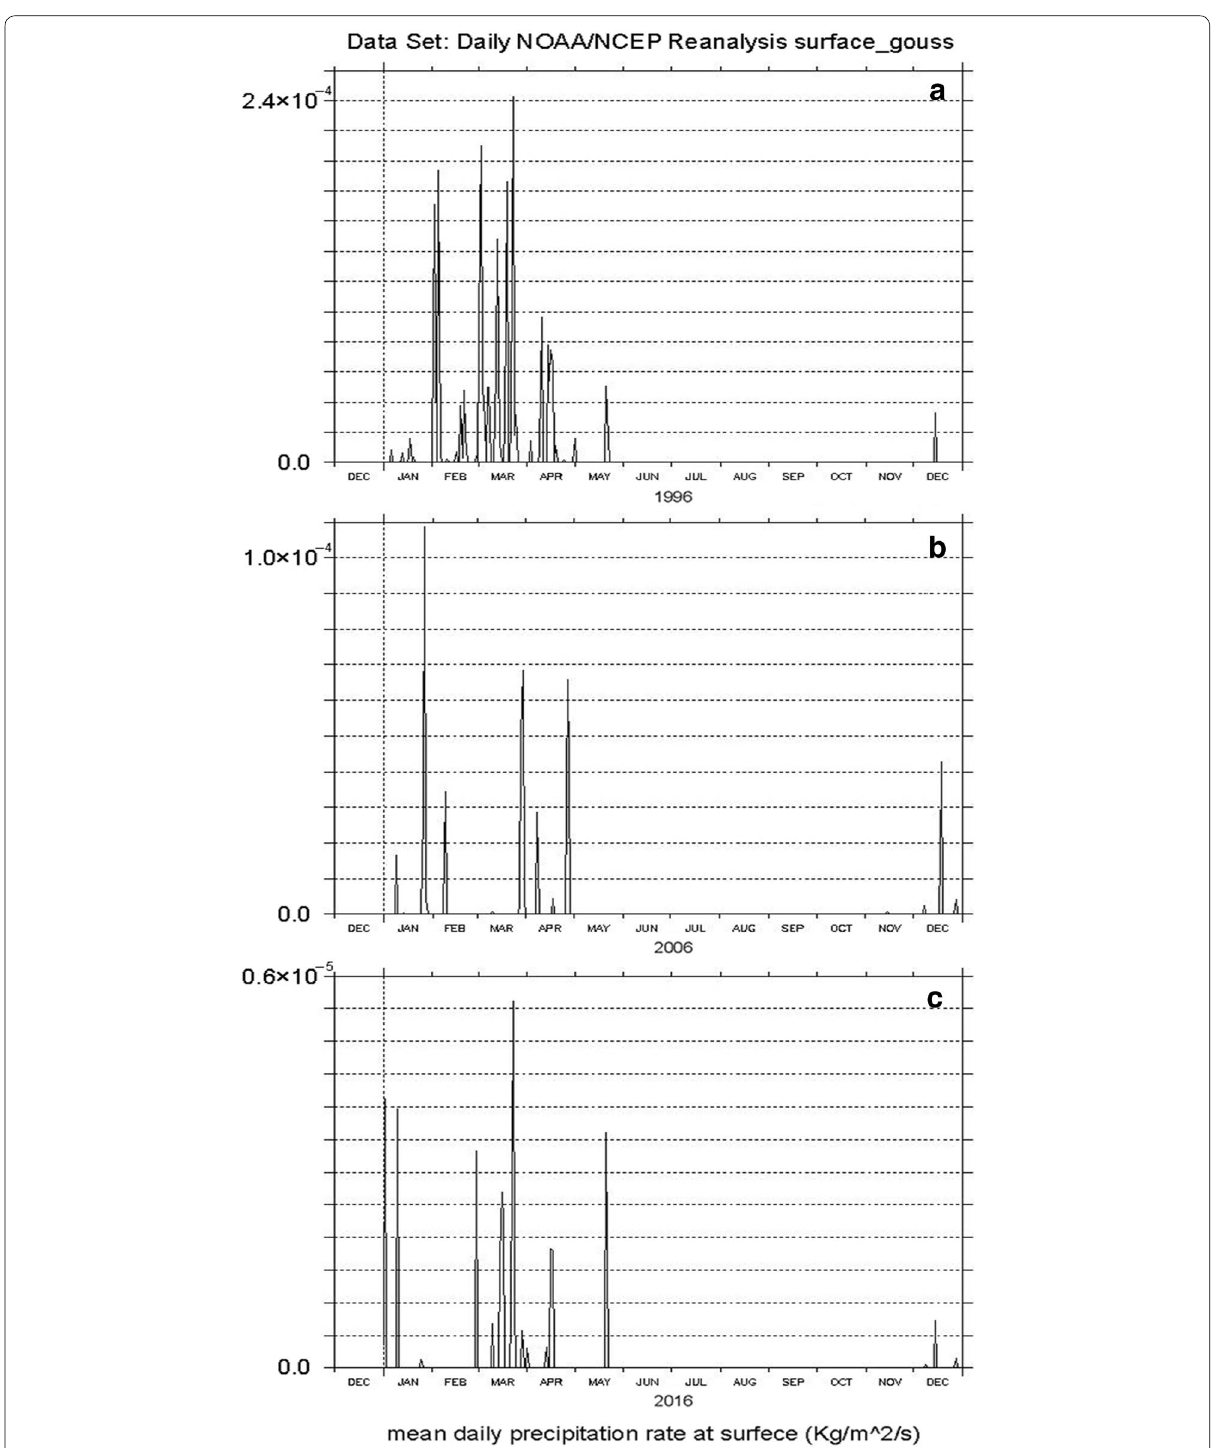
Fig. 4 Daily precipitation rate at surface extracted from NOAA/NCEP reanalysis data for three time windows a 1996, b 2006, and c